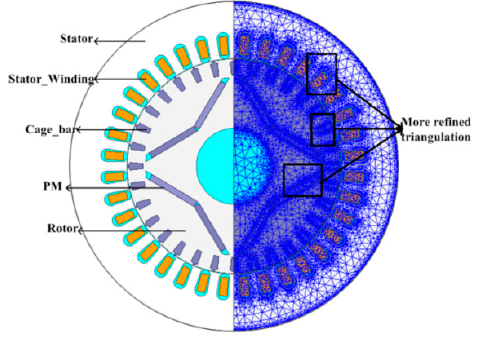
Figure 1. The two-dimensional (2-D) model.